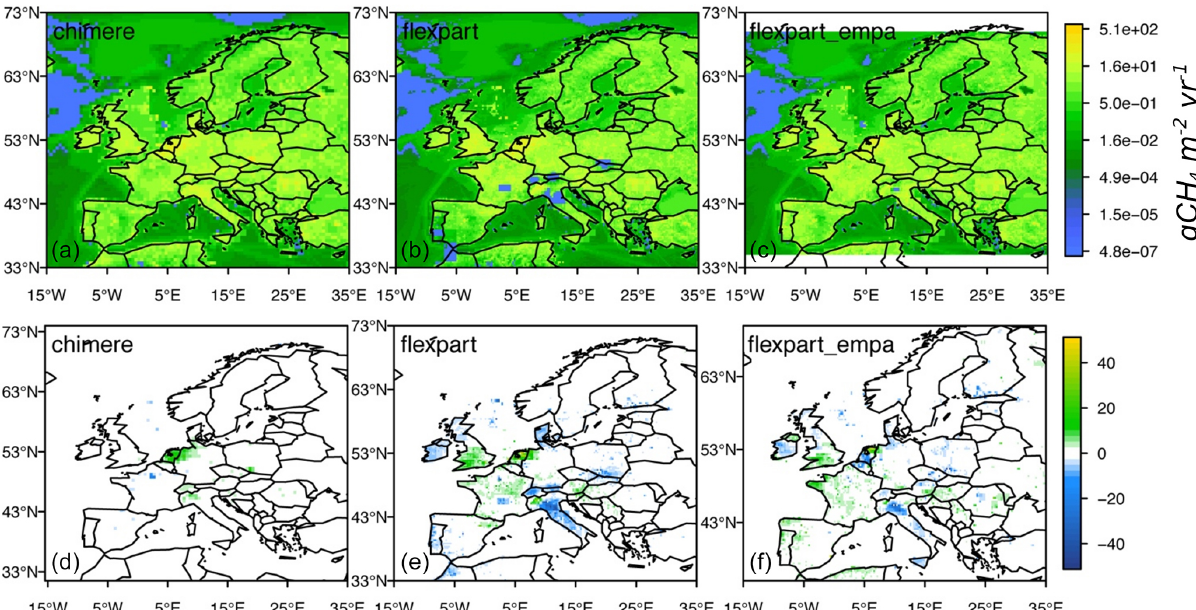
Figure 5. Posterior CH 4 fluxes averaged over 2006–2017 (gCH 4 m − 2 yr − 1 ) from three regional inversions, CHIMERE (LSCE), FLEXPART (NILU) and FLEXPART (EMPA), shown with a log-base-2 color scale (a–c) and the flux increments (posterior-prior) (gCH 4 m − 2 yr − 1 ) shown on a linear color scale (d–f)